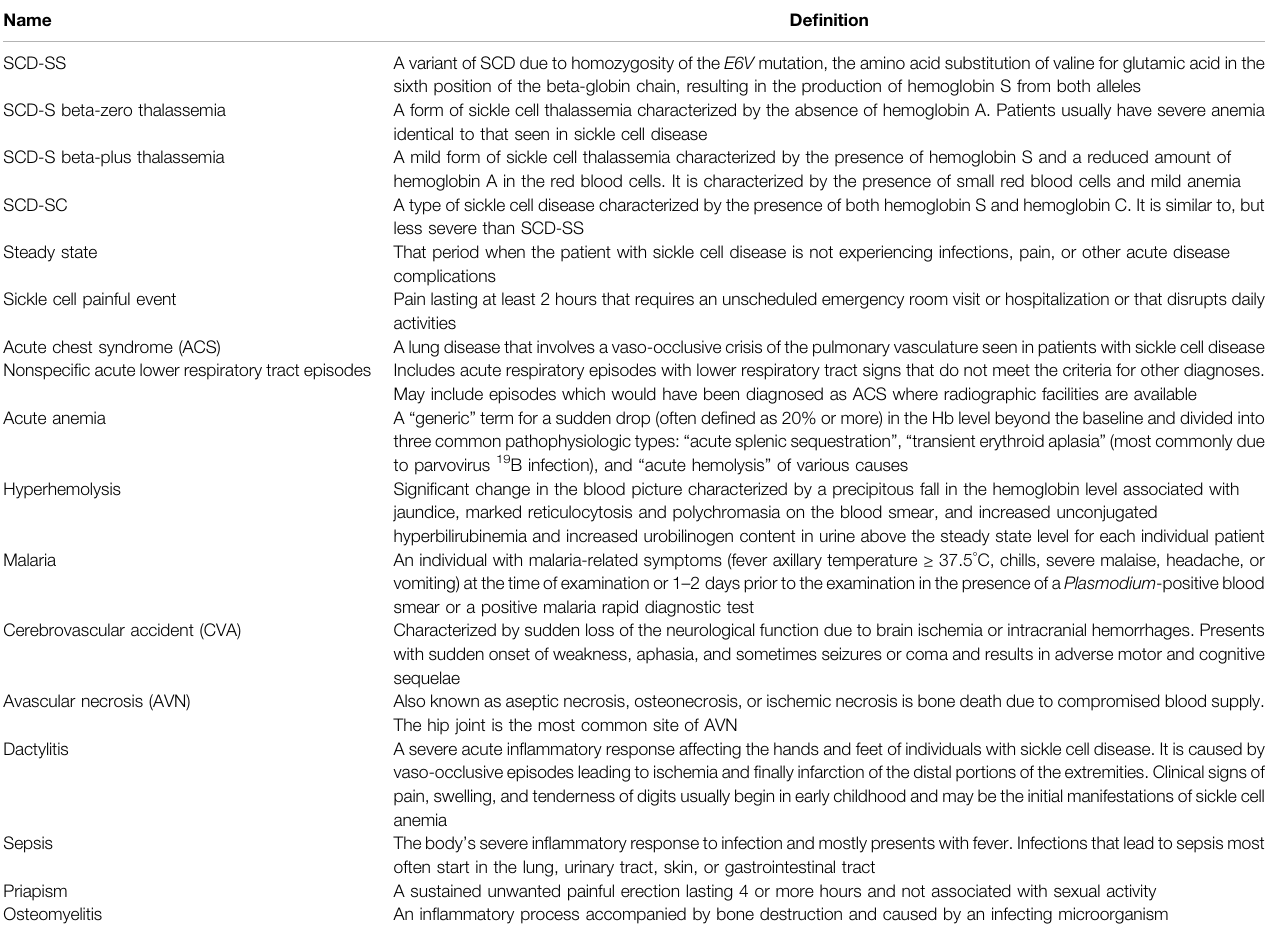
TABLE 1 | De fi nition of SCD terms. Name De fi nition SCD-SS SCD-S beta-zero thalassemia